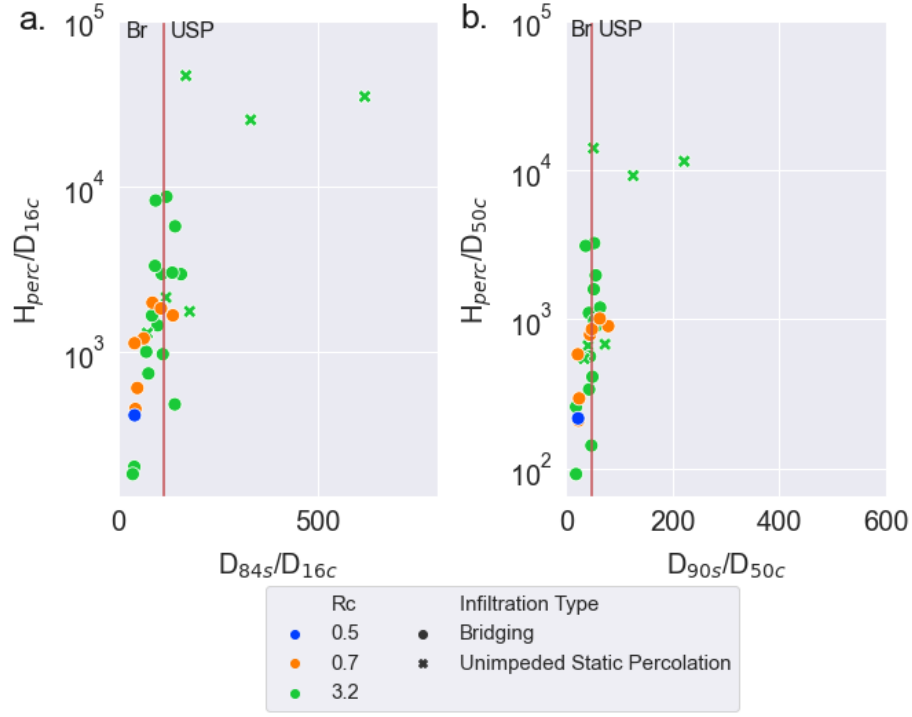
Figure 7. Maximum dimensionless infiltration of fine particles into the substrate: ( a ) Hperc/D16c vs. D84s/D16c and ( b ) H perc / D 50 c vs. D 90 s / D 50 c . The red lines are the thresholds proposed by